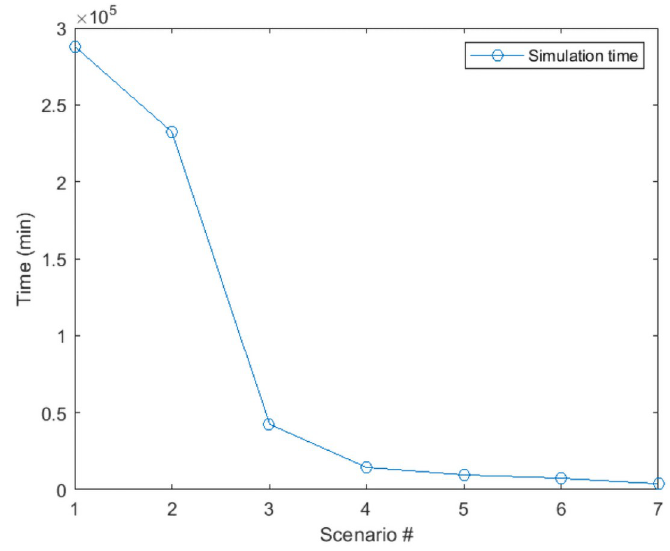
Fig 7. Simulation time for different optimization times